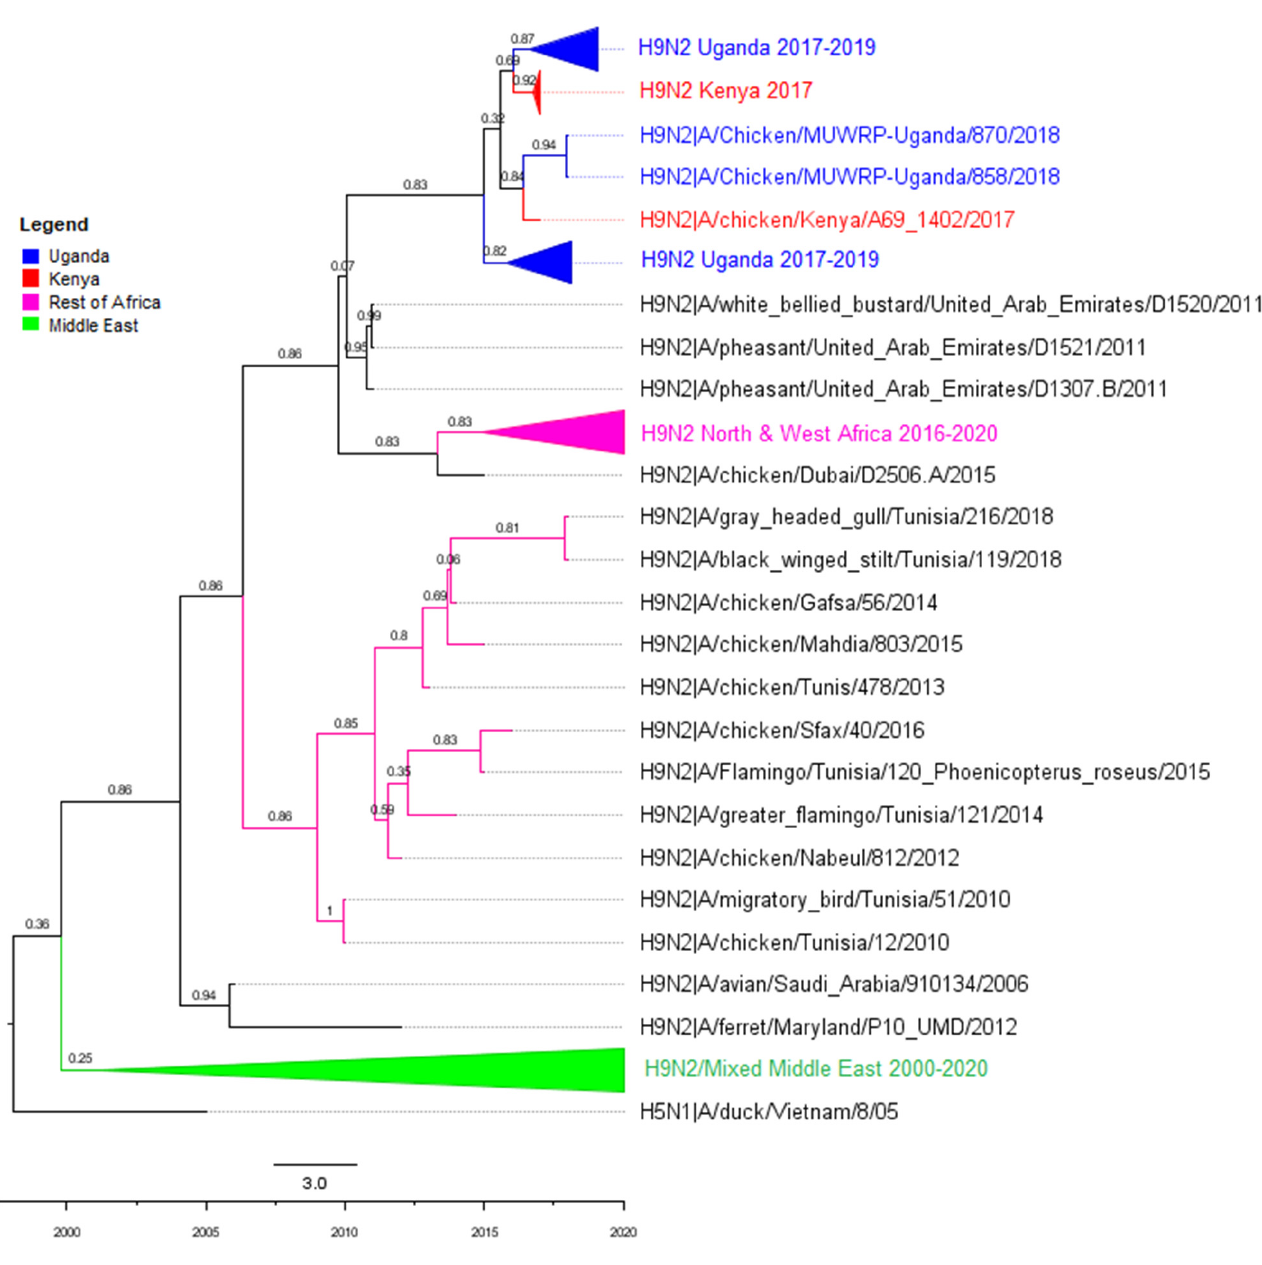
Figure A6. Phylogenetic tree for MP. Ugandan viruses are highlighted in blue, Kenyan in red, North and West African countries in pink, and the Middle East in the green clade. tMRCA for Uganda is December 2014. Posterior probabilities are shown on the branches. Scales represent substitutions and time.